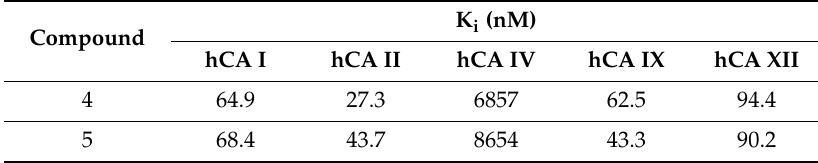
Table 1. hCA I, II, IV, IX, and XII in Vitro Inhibition Data with NSAID-CAI Compounds by the Stopped-Flow CO 2 Hydrase Assay